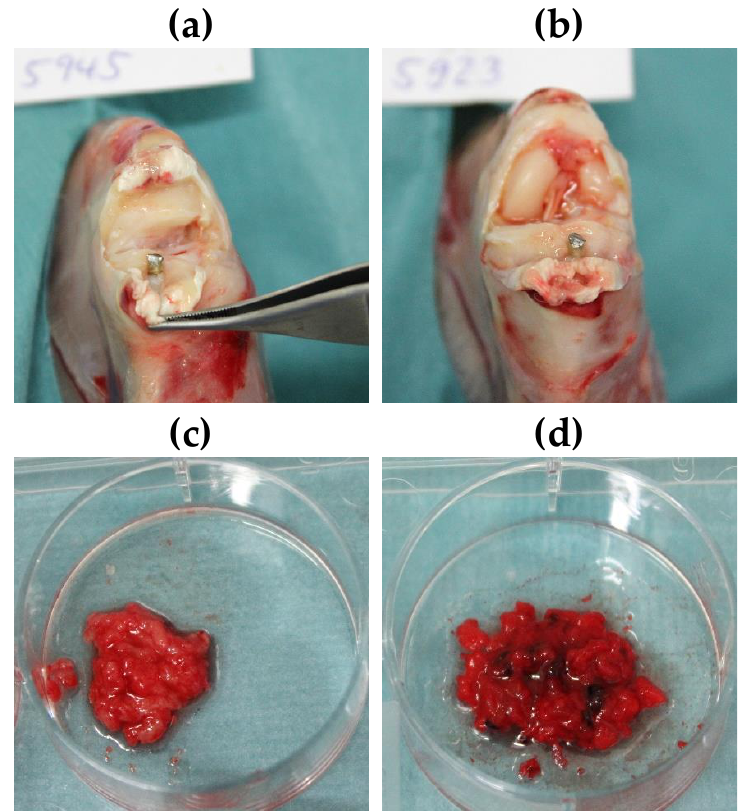
Figure 5. ( a ) and ( b ) Exemplary images of the knee joint postmortem of animals treated with ( a ) SML item and ( b ) blank item. ( c ) and ( d ) Exemplary images of bone marrow after explantation of ( c ) SML item and ( d ) blank item. ( c ) Physiological bone marrow was found in 11 of 12 animals. This equals a cure rate = 8%. ( d ) Fragmented and hemorrhagic aspects indicating osteomyelitis were found in 4 of 12 animals. This equals to a cure rate of 67%.